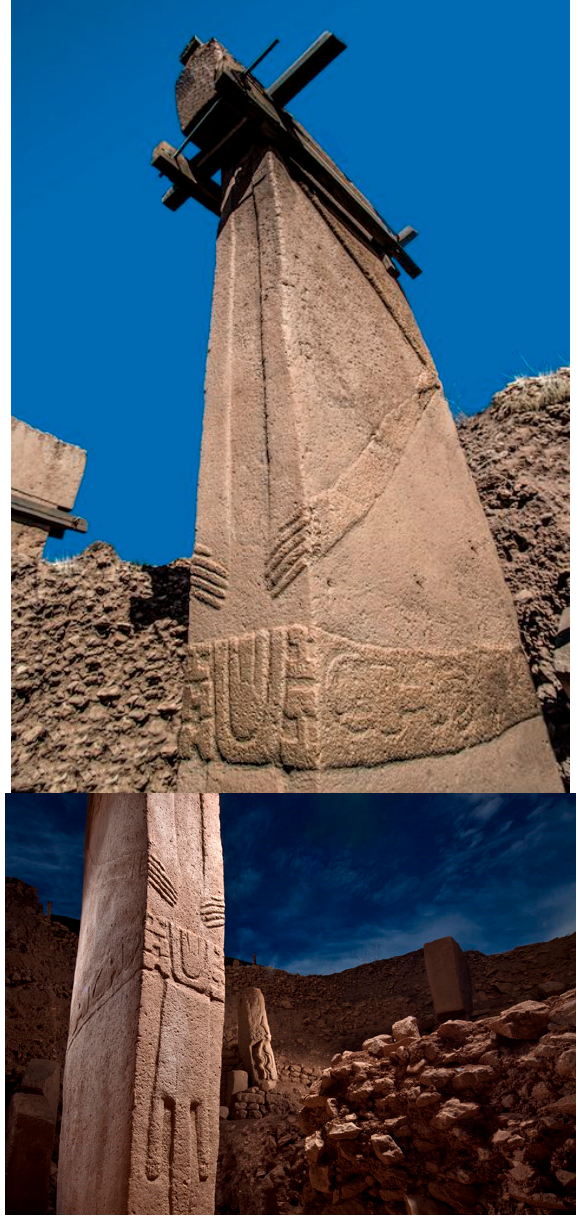
Figure A1. Photographs of anthropomorphic pillars from Göbekli Tepe, showing clear detail of arms, hands, belt, and loincloth. These pillars reached as much as 5 m in height and were centrally located in each enclosure. (Google